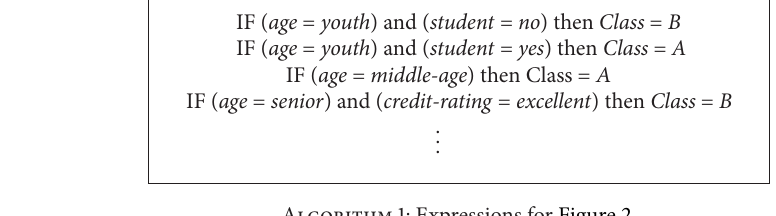
Algorithm 1: Expressions for Figure 2.